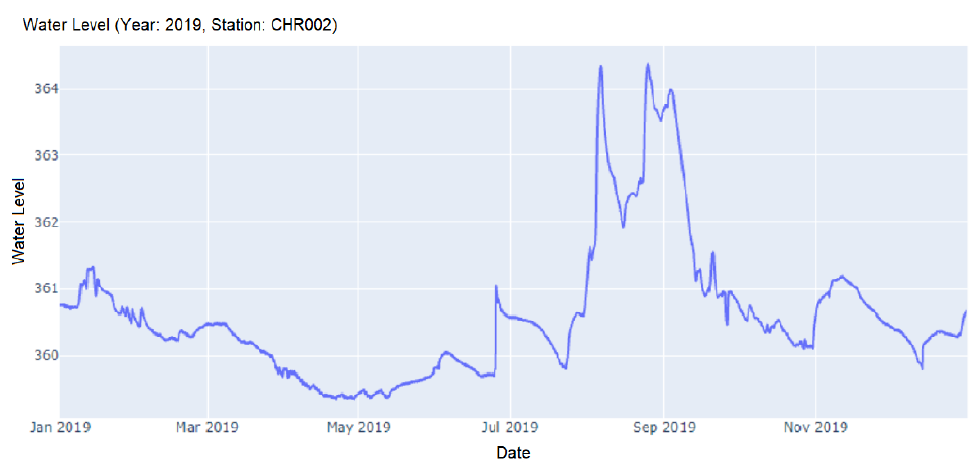
Figure 10. Station ‘CHR002’ in Cluster 3 which was incorrectly identified as Cluster